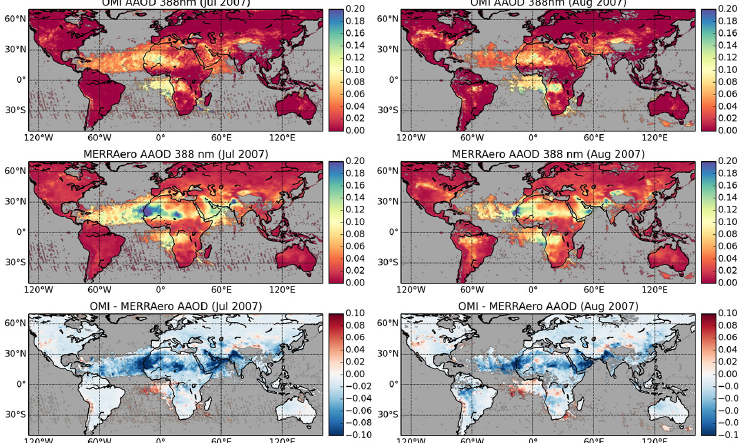
Figure 3. Monthly mean of OMI UV AAOD (top) at 388nm and MERRAero-simulated AAOD (middle) for July (left) and August (right) 2007. Difference of AAOD OMI minus MERRAero (bottom